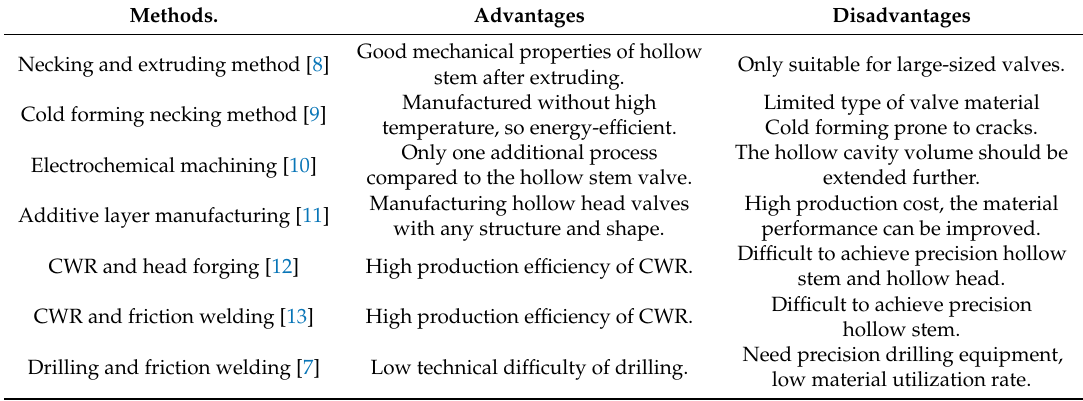
Table 1. Comparison of different manufacturing methods for HHSVs. CWR: cross wedge rolling.